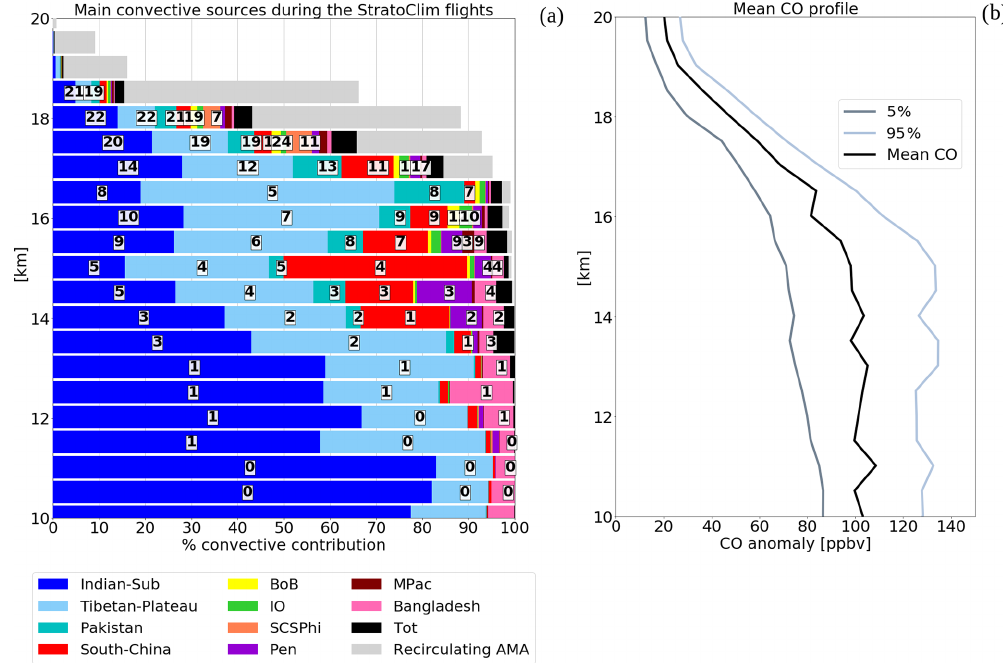
Figure 10. Overall convective contribution and source regions for each single flight. Colours refer to the mask of Fig. 3.